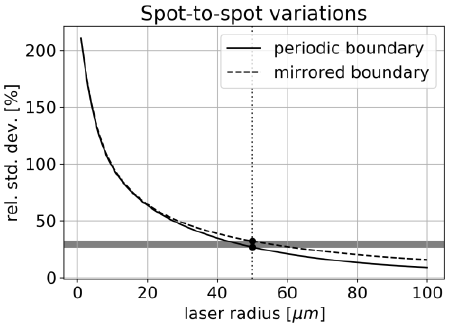
Figure 15. Expected spot-to-spot signal variation for cathode sample.